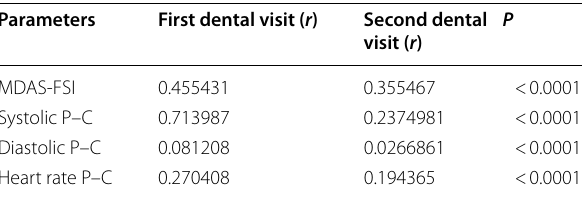
Table 7 Pearson’s correlation coefficient evaluation of every parameters